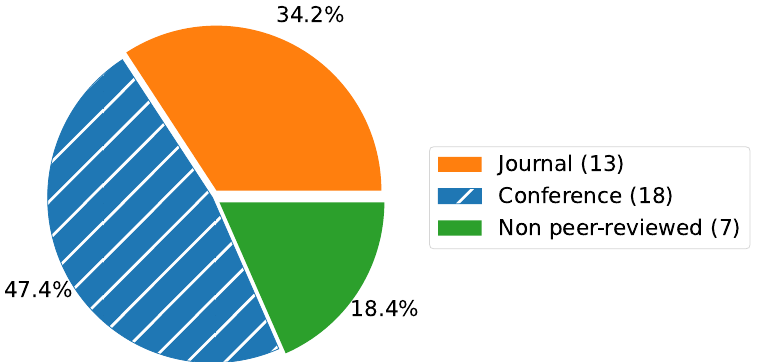
Figure 5. Share of the publication type of 38 included